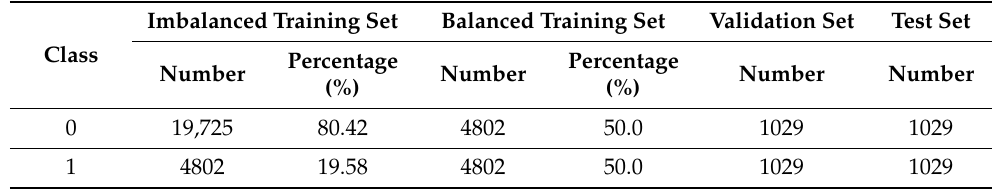
Table 1. Imbalanced training, balanced training, validation, and test sets were constructed from EyePaCS